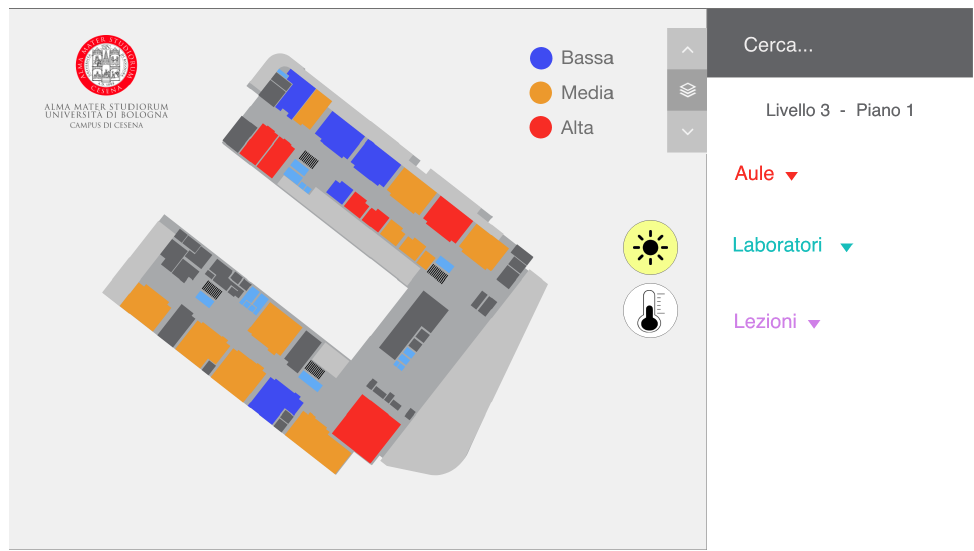
Figure 8. The UI of the final version created after the interviews starting from the second prototype. We kept the legend, and the icons for brightness and temperature, and we changed the color for the selected